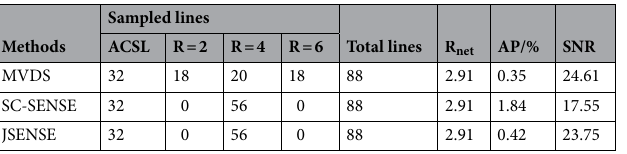
Table 5. The comparison of reconstruction images using MVDS method, SC-SENSE method and JSENSE method.